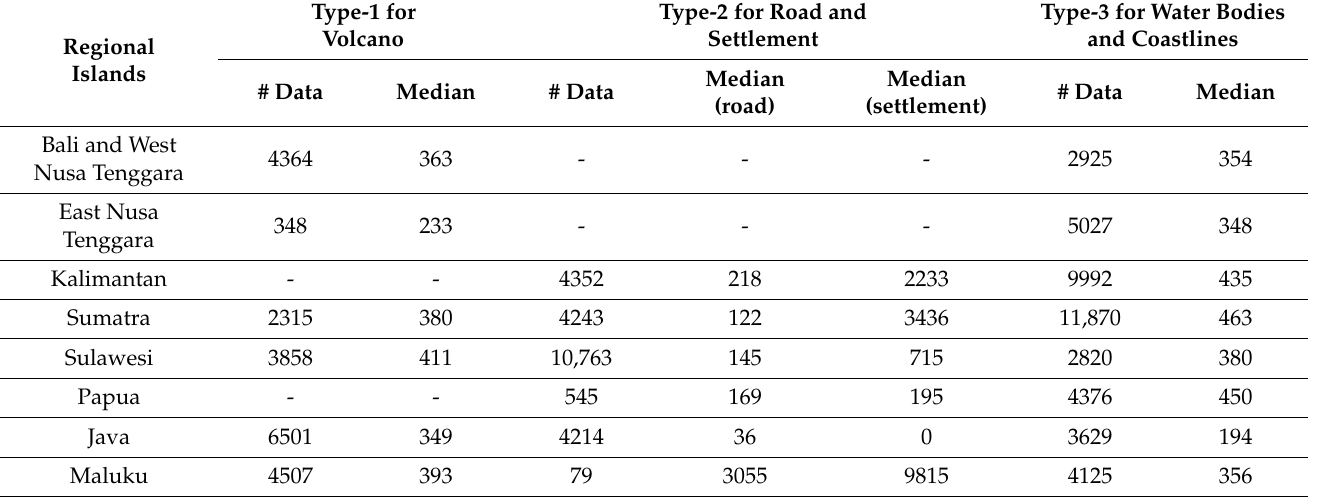
Table 3. Near distance between thermal anomaly (type-1, type-2, type-3) locations and permanent geo-features based on island regions. The unit of median values of near distance is in meters. # is the total number of